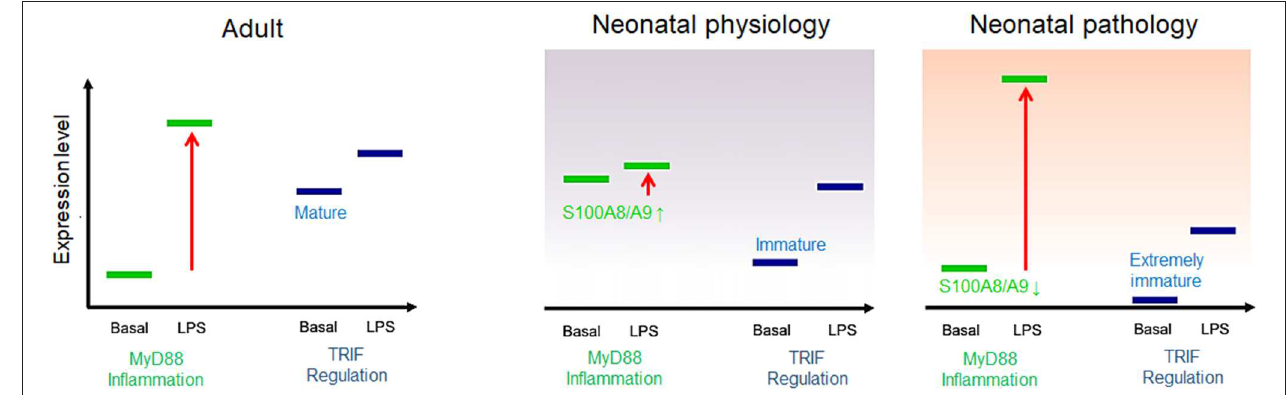
FIGURE 3 | Model of adult and neonatal regulation of lipopolysaccharide (LPS)-responsive gene expression. In healthy adults, MyD88-dependent pro-inflammatory genes are not expressed at baseline but strongly induced by LPS; the basal expression tonus of regulatory TIR domain-containing adaptor protein-inducing interferon (IFN)- β (TRIF)-dependent genes in adults is high and moderately increased by LPS stimulation. In healthy neonates, MyD88-dependent gene expression is physiologically pre-activated by S100A8/A9 and thereby tolerized toward subsequent LPS activation. TRIF-dependent genes are barely expressed at baseline but initiated by a first LPS challenge after birth. In S100A8/A9-deficient neonates, insufficient tolerization of the MyD88-dependent pro-inflammatory response and/or an immature expression tonus or altered postnatal initiation of TRIF-dependent regulatory gene programs results in unregulated hyperinflammatory LPS responses, increasing the risk of severe